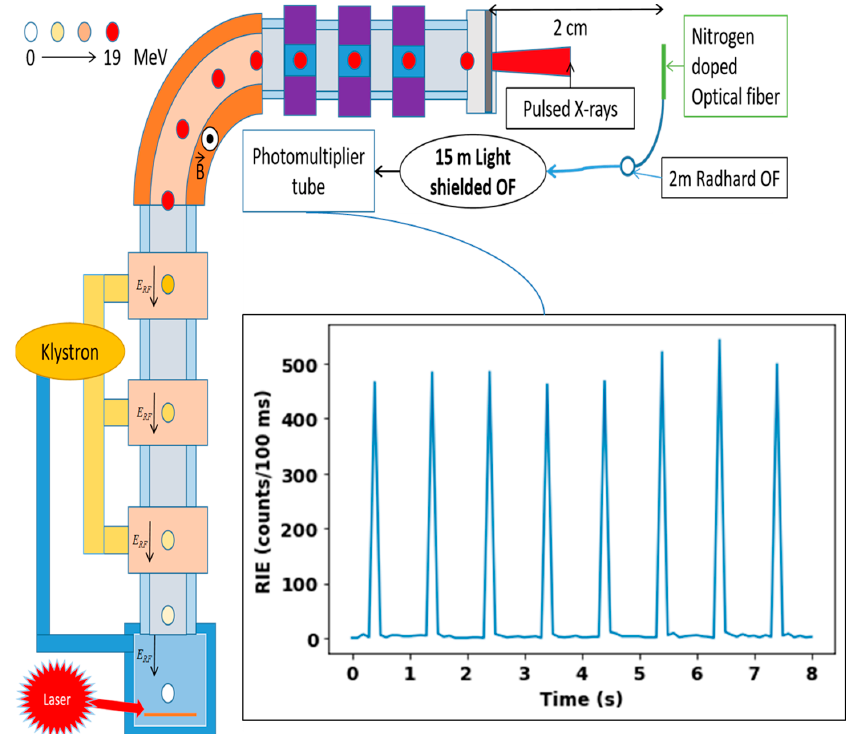
Figure 2. ELSA experimental irradiation area and experimental setup developed to measure the RIE induced in the N-doped fiber under test. The inset describes the temporal evolution of the RIE signal for 8 successive ELSA X-ray pulses.